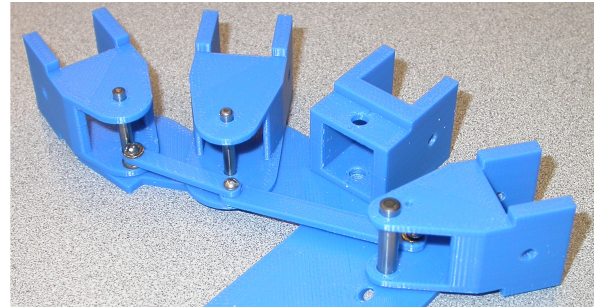
Figure 18. Prototype of the finger abduction